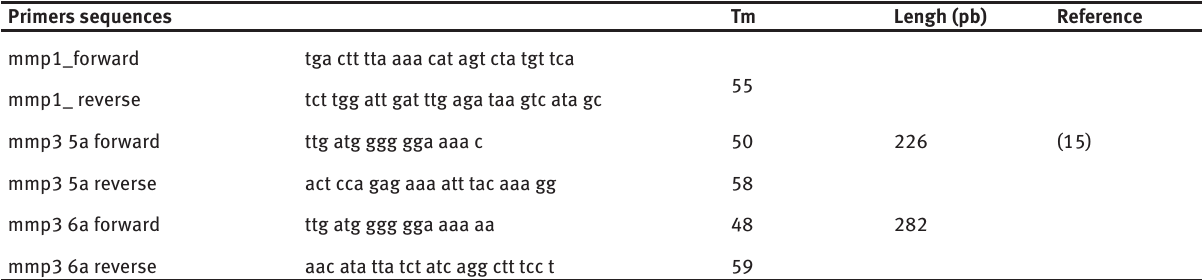
Table 1: The pairs of primers specific to the amplification of the alleles of MMP1 and MMP3. Primers